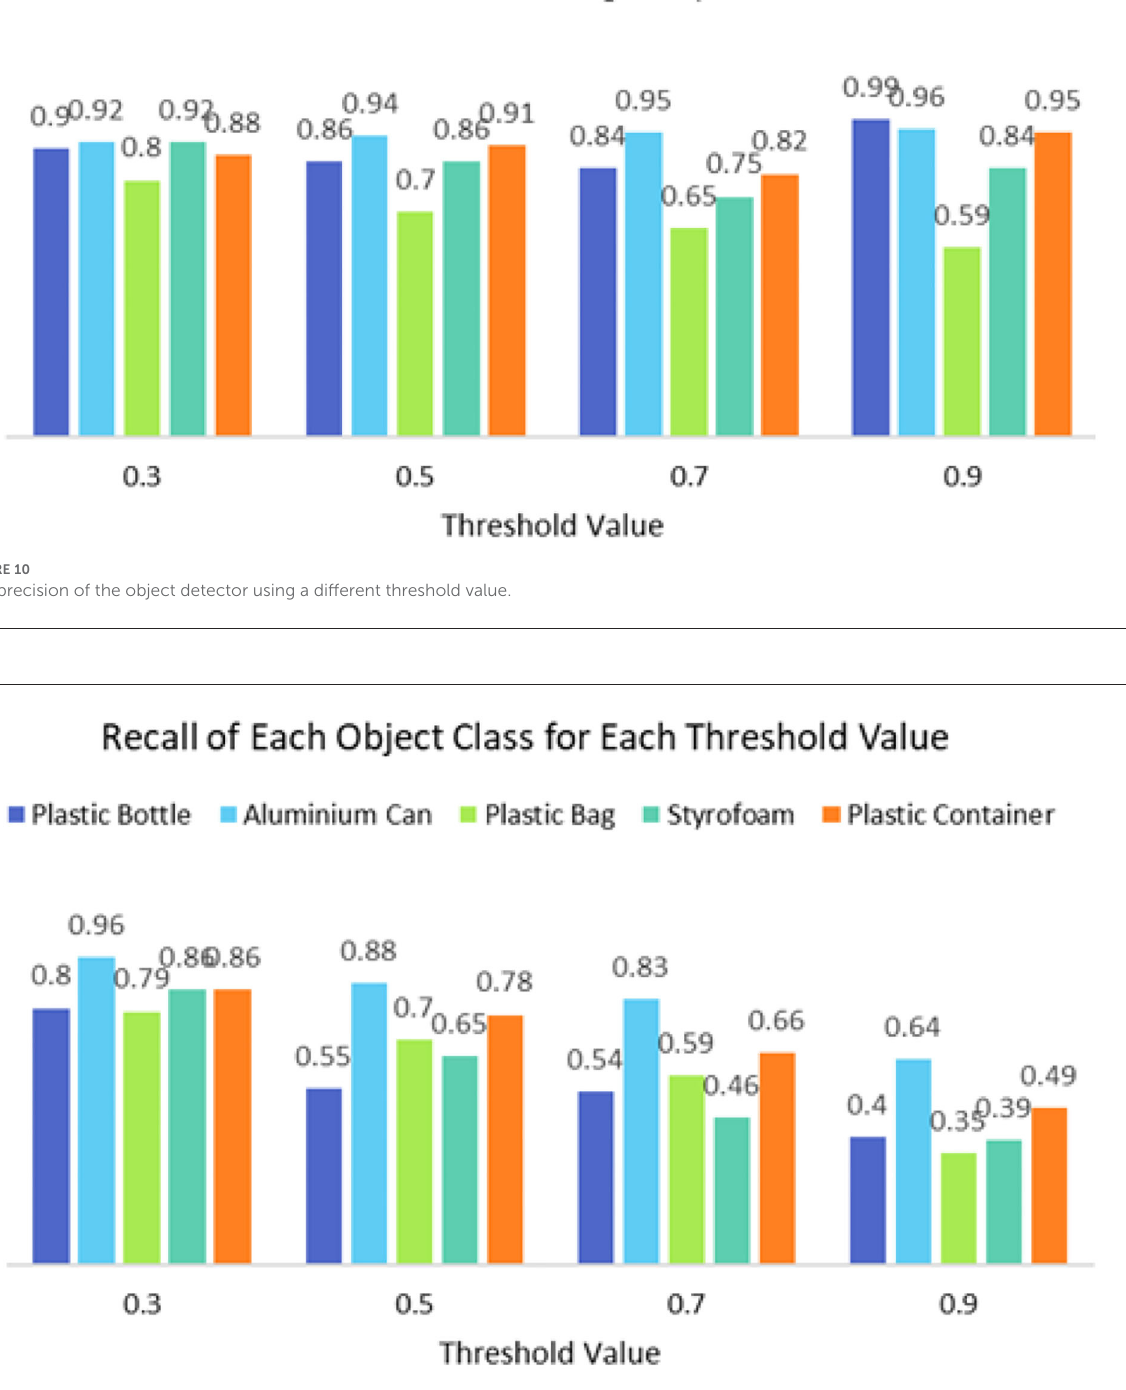
FIGURE11 The recall of the object detector using a different threshold